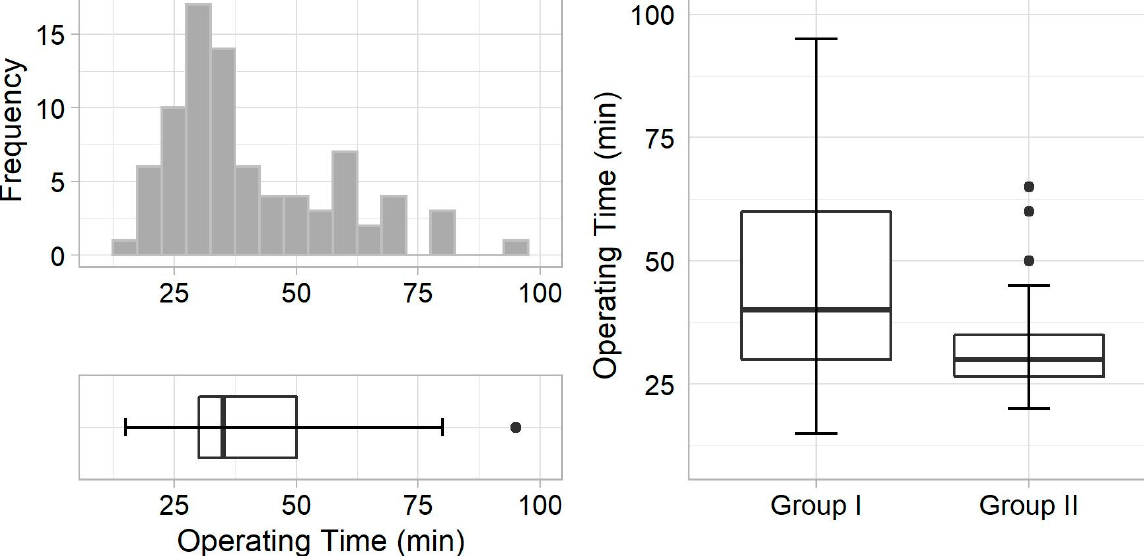
Figure 3. Left —Operating time frequency ( upper ) and distribution ( bottom ) in all patients in both groups. Right , com- parison of operating time distribution between two groups.